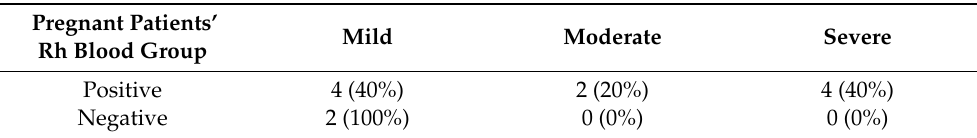
Table A2. Mild, moderate, and severe forms of COVID-19 in second and third trimester pregnant patients, according to Rh blood group.